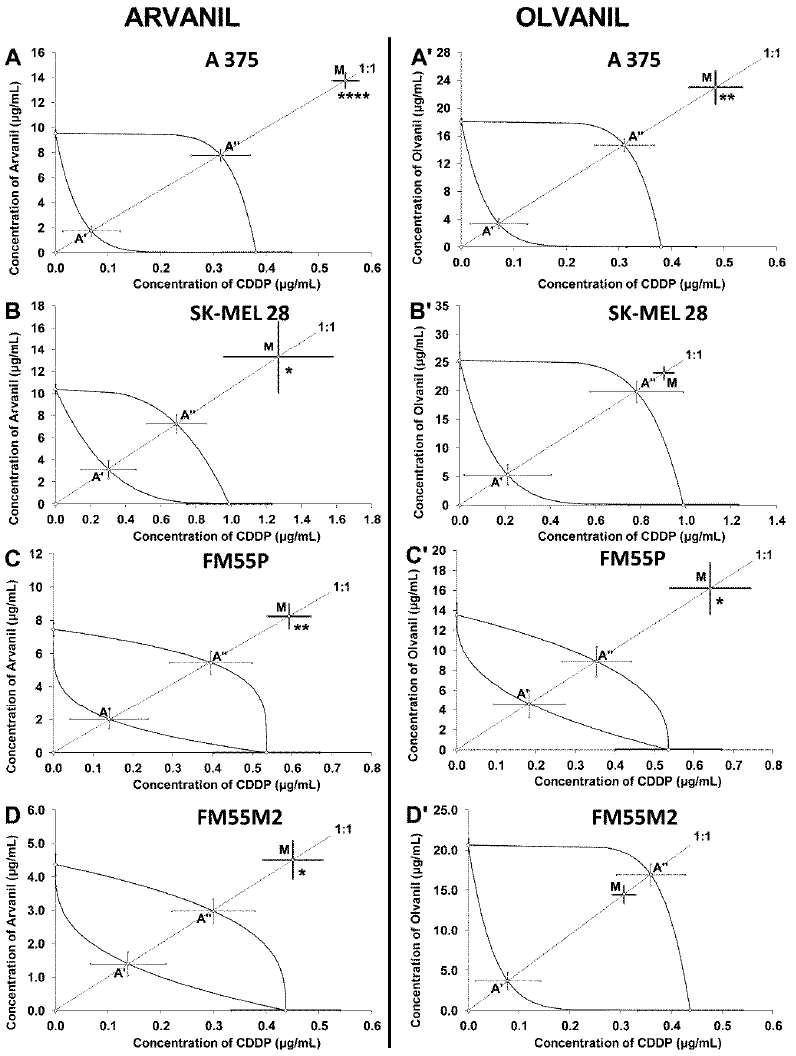
Figure 10. Isobolograms showing interactions between arvanil, olvanil, and cisplatin (CDDP) with respect to their anti-proliferative effects on A375 ( A , A’ ), SK–MEL 28 ( B , B’ ), FM55P ( C , C’ ), and FM55M2 ( D , D’ ) malignant melanoma cell lines measured in vitro by the MTT assay. Points A’ and A” depict the theoretically calculated IC 50add values for both lower and upper isoboles of additivity, respectively. The points M represent the experimentally derived IC 50mix values for total concentration of the mixture of arvanil or olvanil with CDDP that produced a 50% anti-proliferative effect in malignant melanoma cell lines measured in vitro by the MTT assay. * p < 0.05, ** p < 0.01, and **** p < 0.0001 vs. the respective IC 50add value.